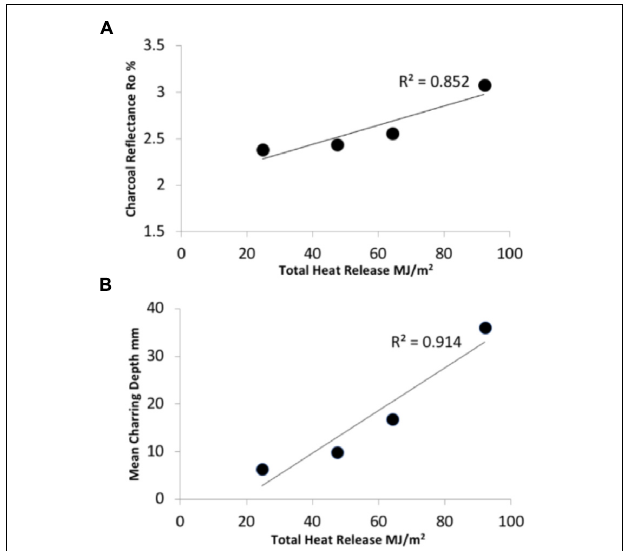
FIGURE 4 | Graphs indicating strong positive correlations between the total heat released during flaming combustion of WRC in respect to (A) charcoal reflectance and (B) mean charring depth attained. The mean of 90 measurements is represented by each data point on both